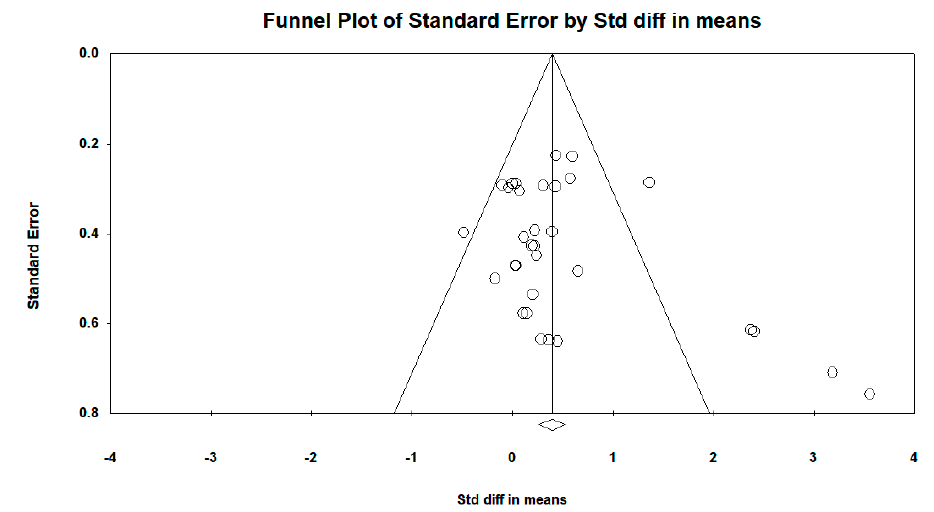
Figure 5. Funnel plot diagram of the standard error ( y -axis) and the standardized mean difference (SMD) ( x -axis): intra-group pre–post difference in the intervention group with resistance therapy in all follow-ups.